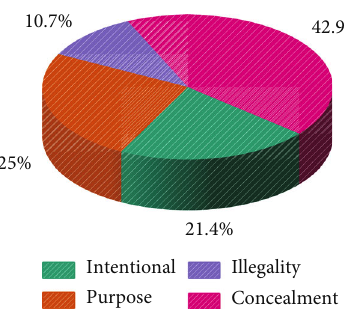
Figure 6: The proportion of various characteristics of domestic